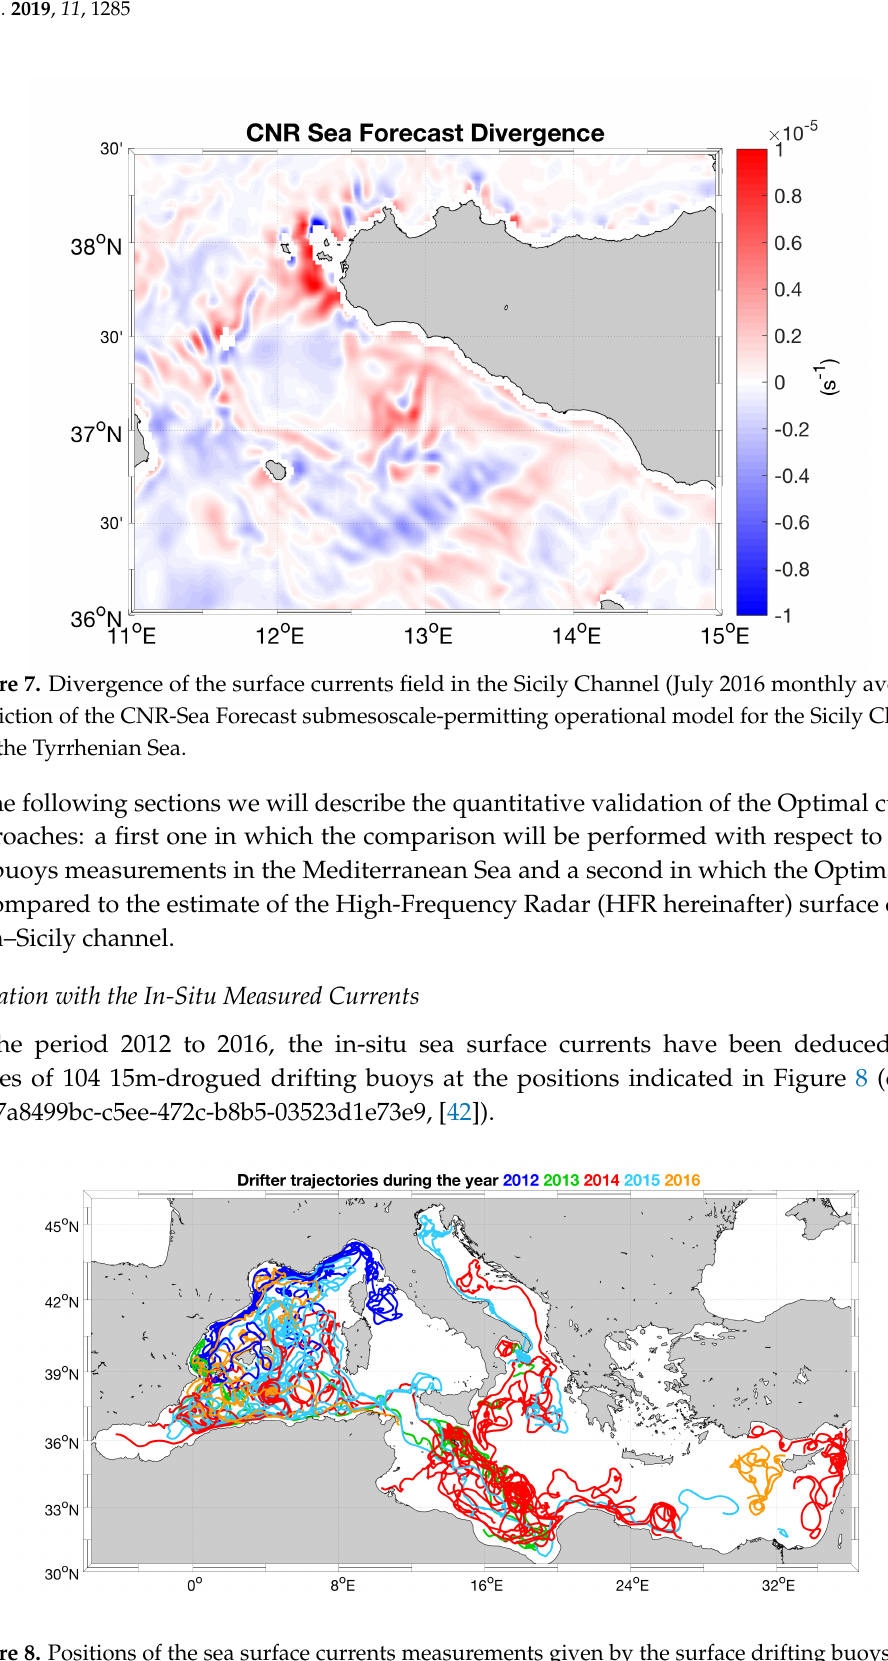
Figure 8. Positions of the sea surface currents measurements given by the surface drifting buoys in the Mediterranean Area during the period 2012–2016